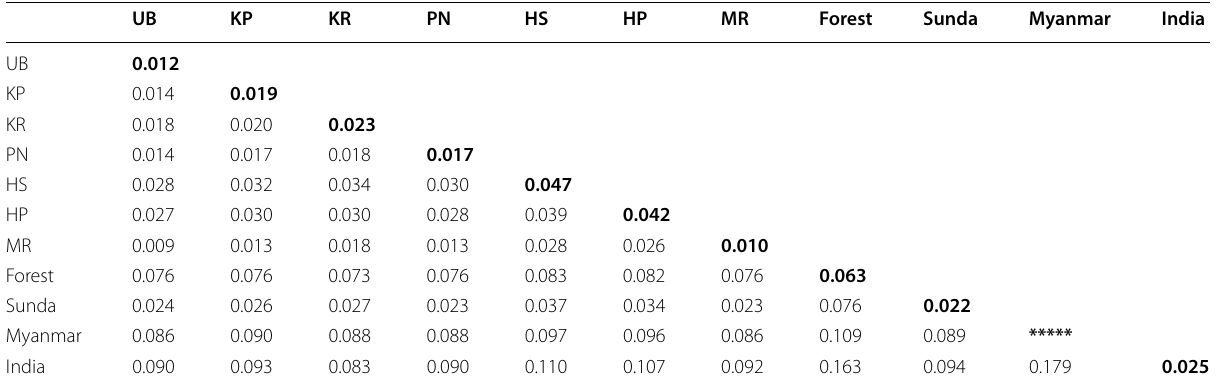
Table 2 The genetic distance of Cynopterus brachyotis among and within (bold) seven habitats on Java island and four lineage from GenBank based on the Kimura-2 parameter